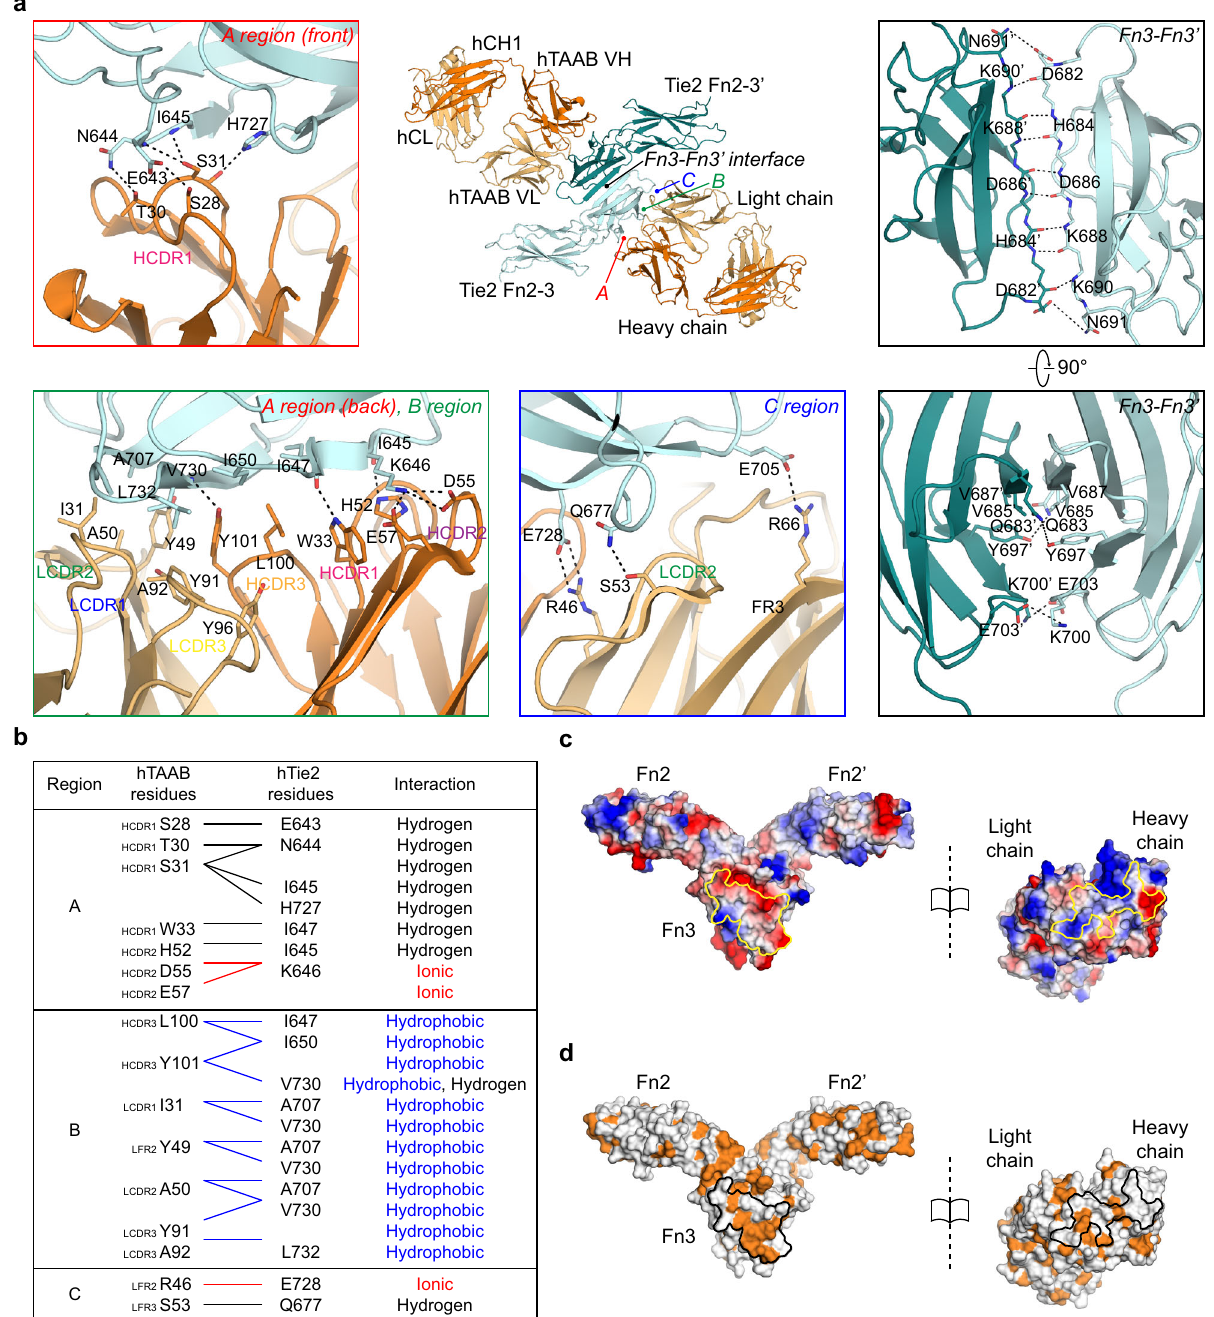
Fig. 3 Interactions of Tie2 Fn3 with hTAAB and homotypic Fn3 interactions. a Close-up view of key molecular interactions (A, B and C regions). Residues involved in the hTie2 Fn3/chimeric hTAAB Fab interaction (red, green, and blue boxes) and hTie2 dimerization (black box) are displayed as sticks and labeled. Hydrogen bonds and electrostatic interactions are indicated by dashed lines. b Key amino acid residues of A, B, and C regions involved in hTAAB binding. Interaction residues of hTAAB are listed on the left, and the corresponding interaction residues of Tie2 are listed on the right. Interactions between residue partners are indicated in red (ionic interaction), black (hydrogen bond), and blue (hydrophobic interaction). c Electrostatic potential of the hTie2 Fn2 – 3/chimeric hTAAB Fab complex, calculated according to the Poisson – Boltzmann equation in PyMOL. The structures are shown as open-book views and surface representations, with color maps re fl ecting electrostatic properties (blue, positively charged; red, negatively charged). The interacting regions are highlighted by a yellow line. d Hydrophobic residues in hTie2 Fn2 – 3 and chimeric hTAAB Fab are presented on the surface, and the interaction interface is marked with a black